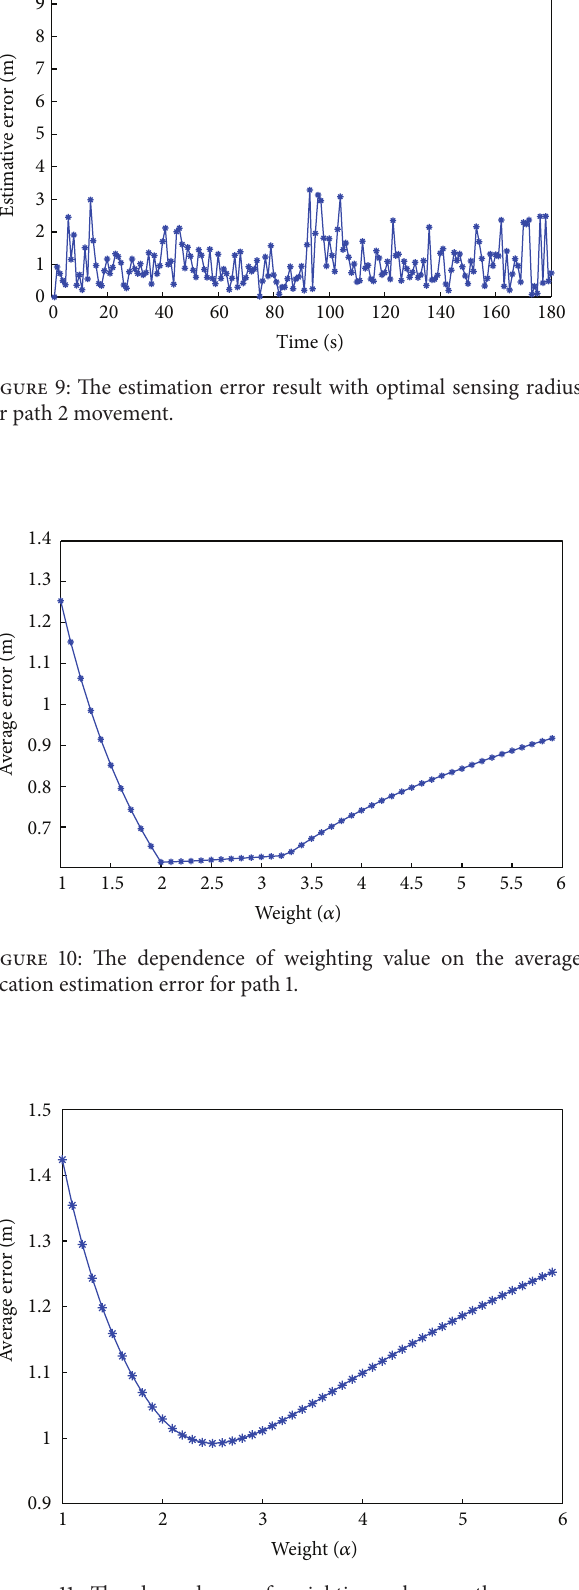
Table1:TheestimationerrorswithcorrespondingvariablesforPath